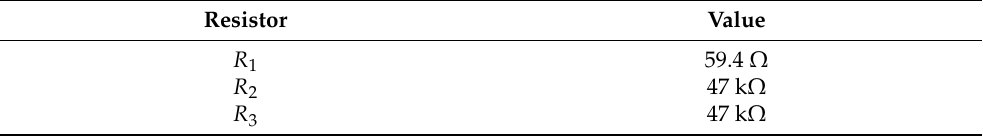
Table 6. CT Wheatstone bridge architecture fixed resistors used in SPICE simulation.